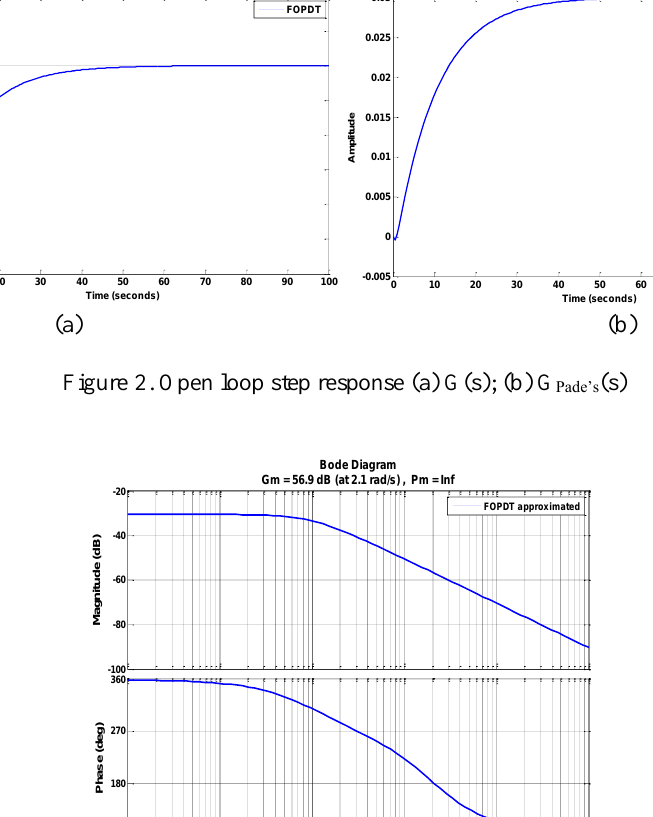
Figure 3. Bode plot of G(s)